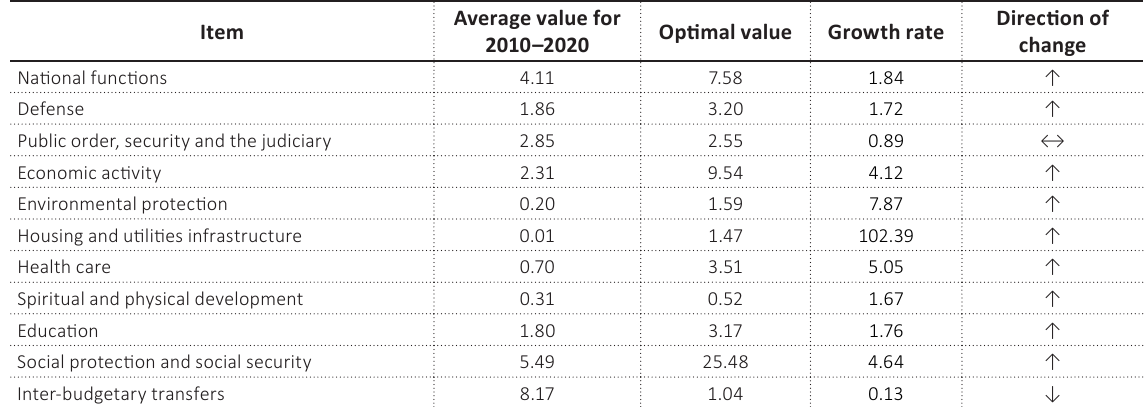
Table 5. Direction and rates of changes in national expenditures, % of